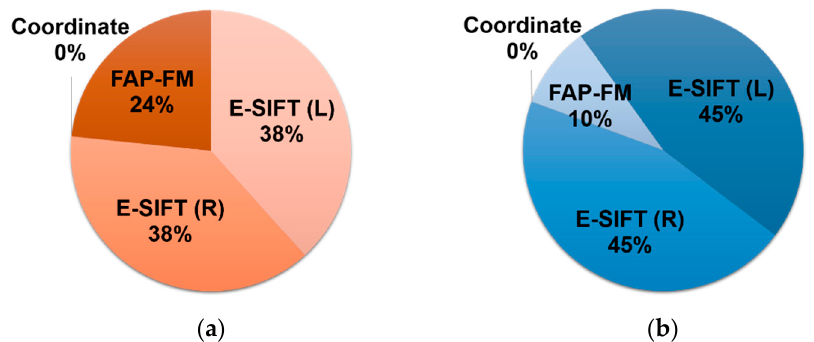
Figure 28. Usage ratio of ( a ) LE used and ( b ) registers used for the proposed E-SIFTs and FAP feature matching.